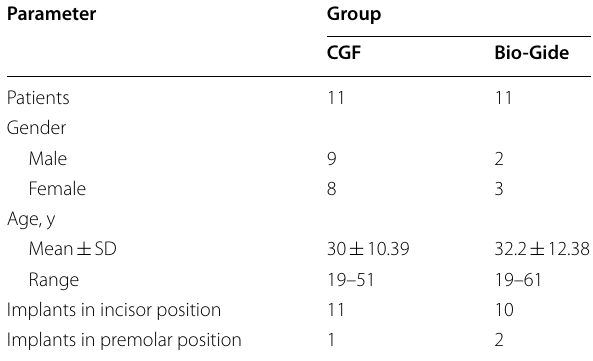
Table 1 Patient and tooth extraction site